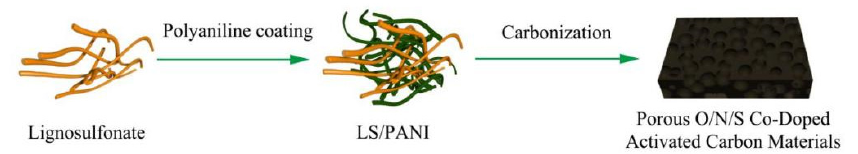
Figure 2. Preparation process of porous O/N/S co-doped activated carbon materials.